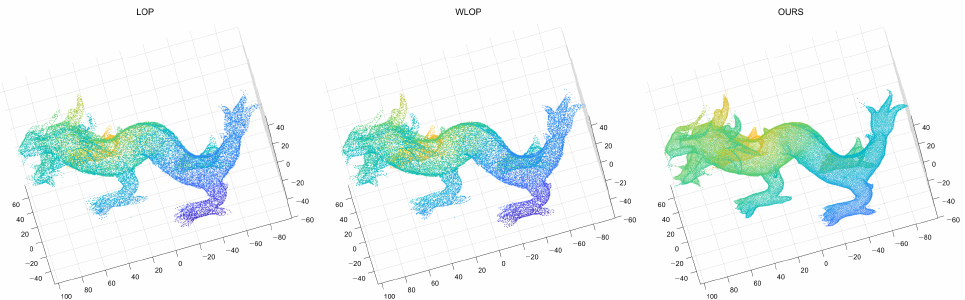
Figure 25. Resampling results of Dragon. ( Left ): LOP, ( Middle ): WLOP, ( Right ): proposed